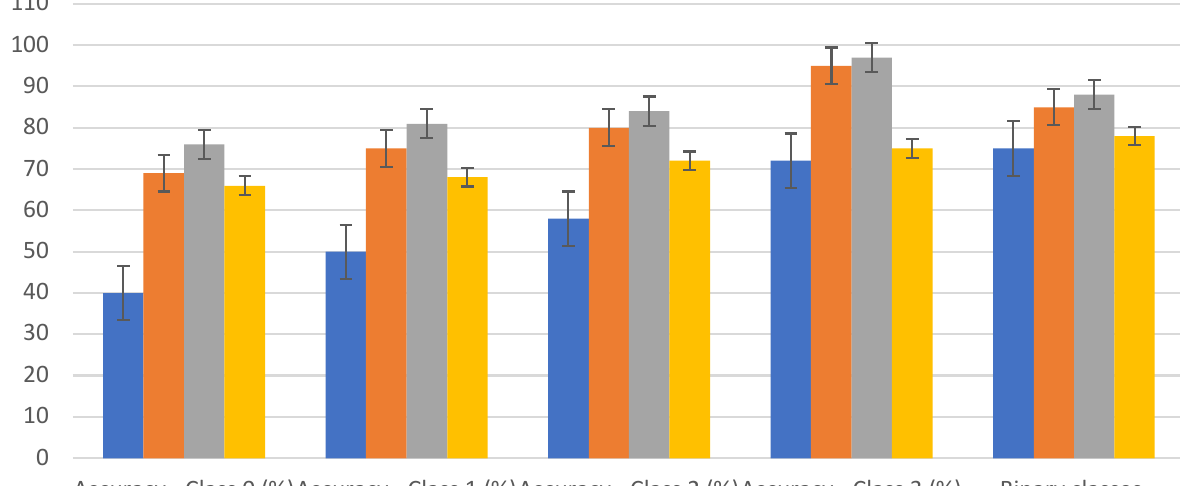
Figure 5. The results of multiclass classification and binary class with error bars among classes using classifiers SVM, DTC, RFC, and QDA. Class 0 is the healthy class, and classes 1–3 are mildly, moderately, and severely diseased